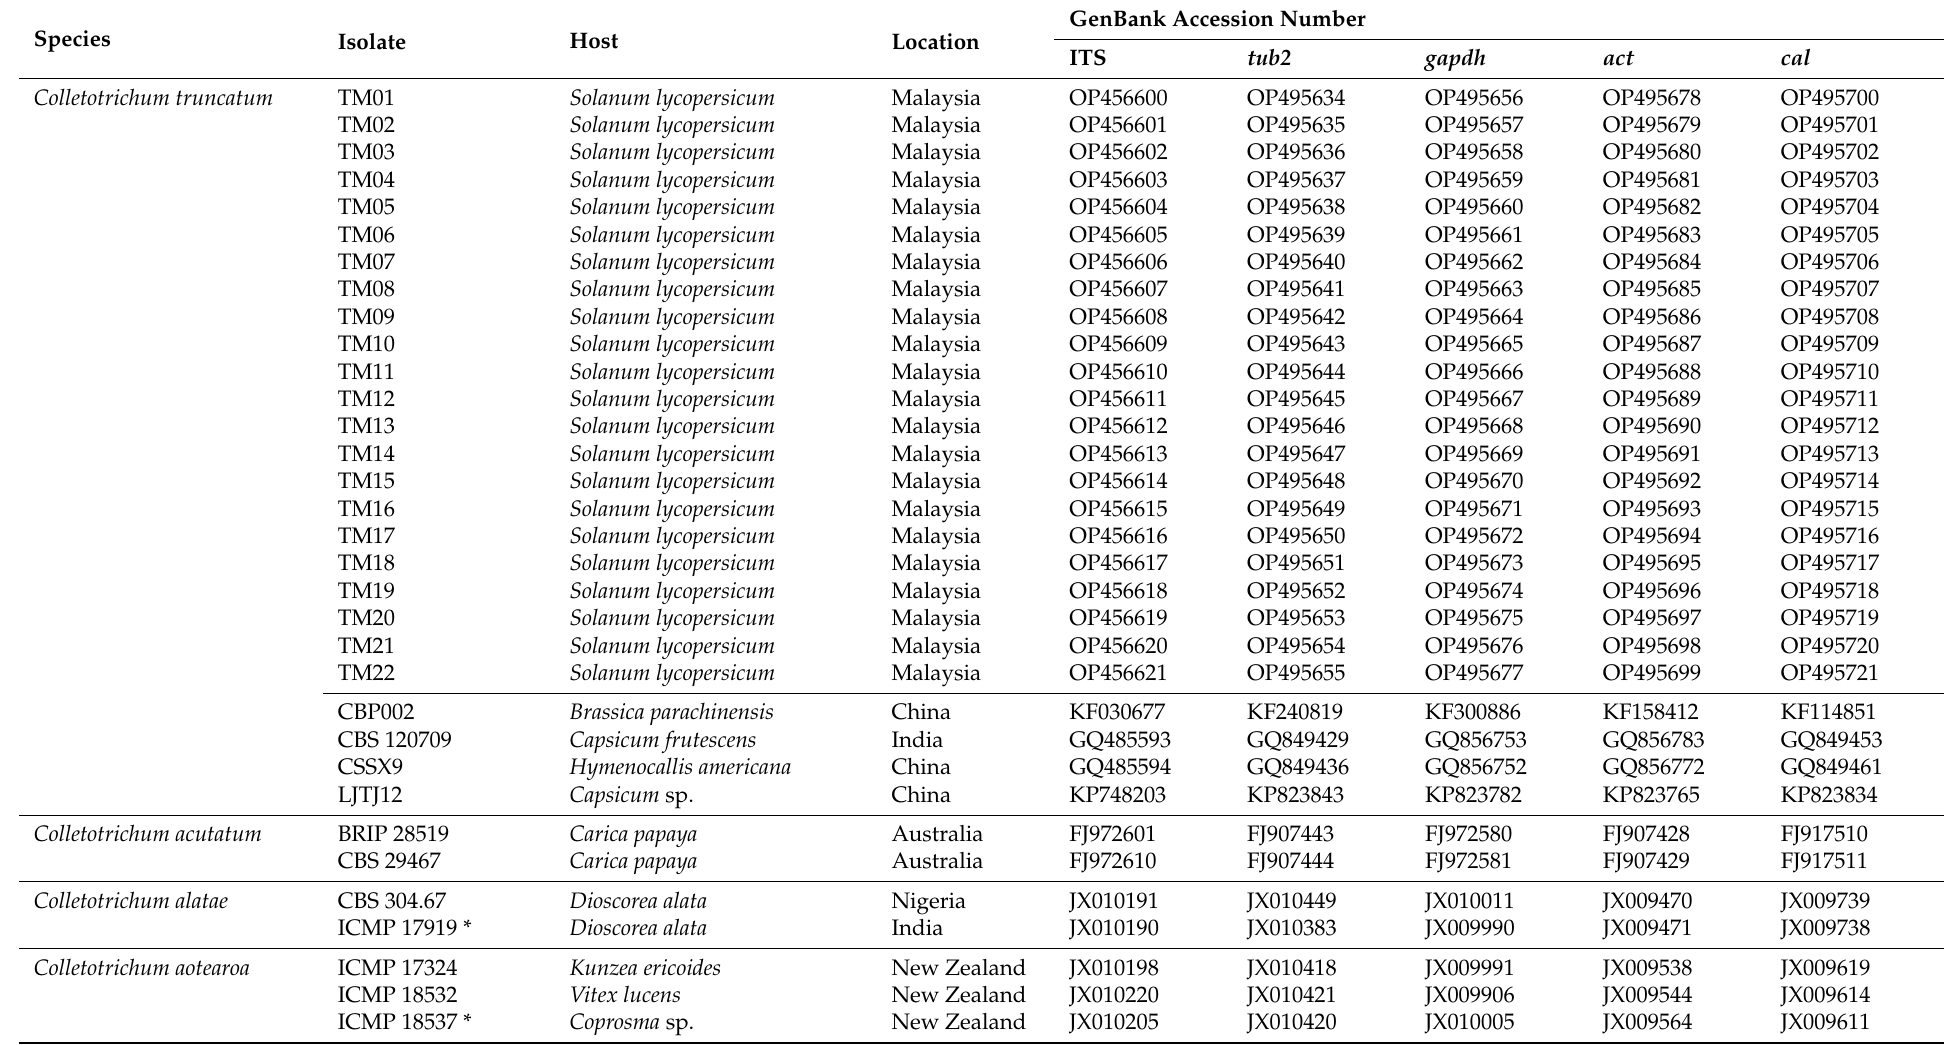
Table 2. Fungal isolates obtained from the present study and reference species used for sequence comparisons and phylogenetic analysis of Colletotrichum truncatum